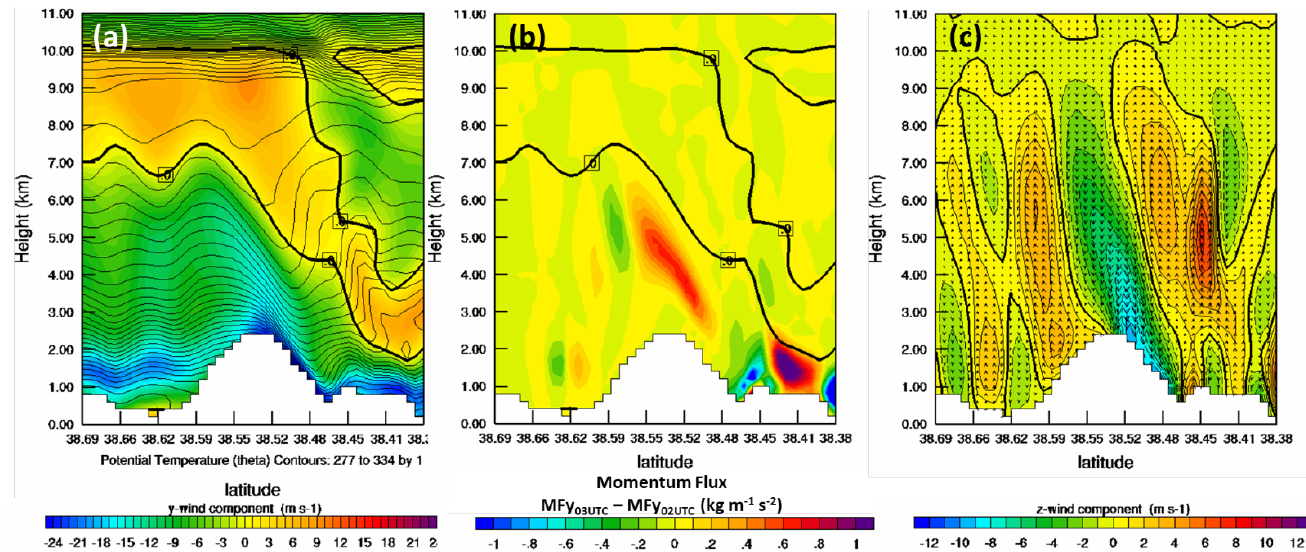
Figure 7. ( a ) Potential temperature (line contours in K) and meridional wind speed (color scale in m s − 1 ) on 14 February